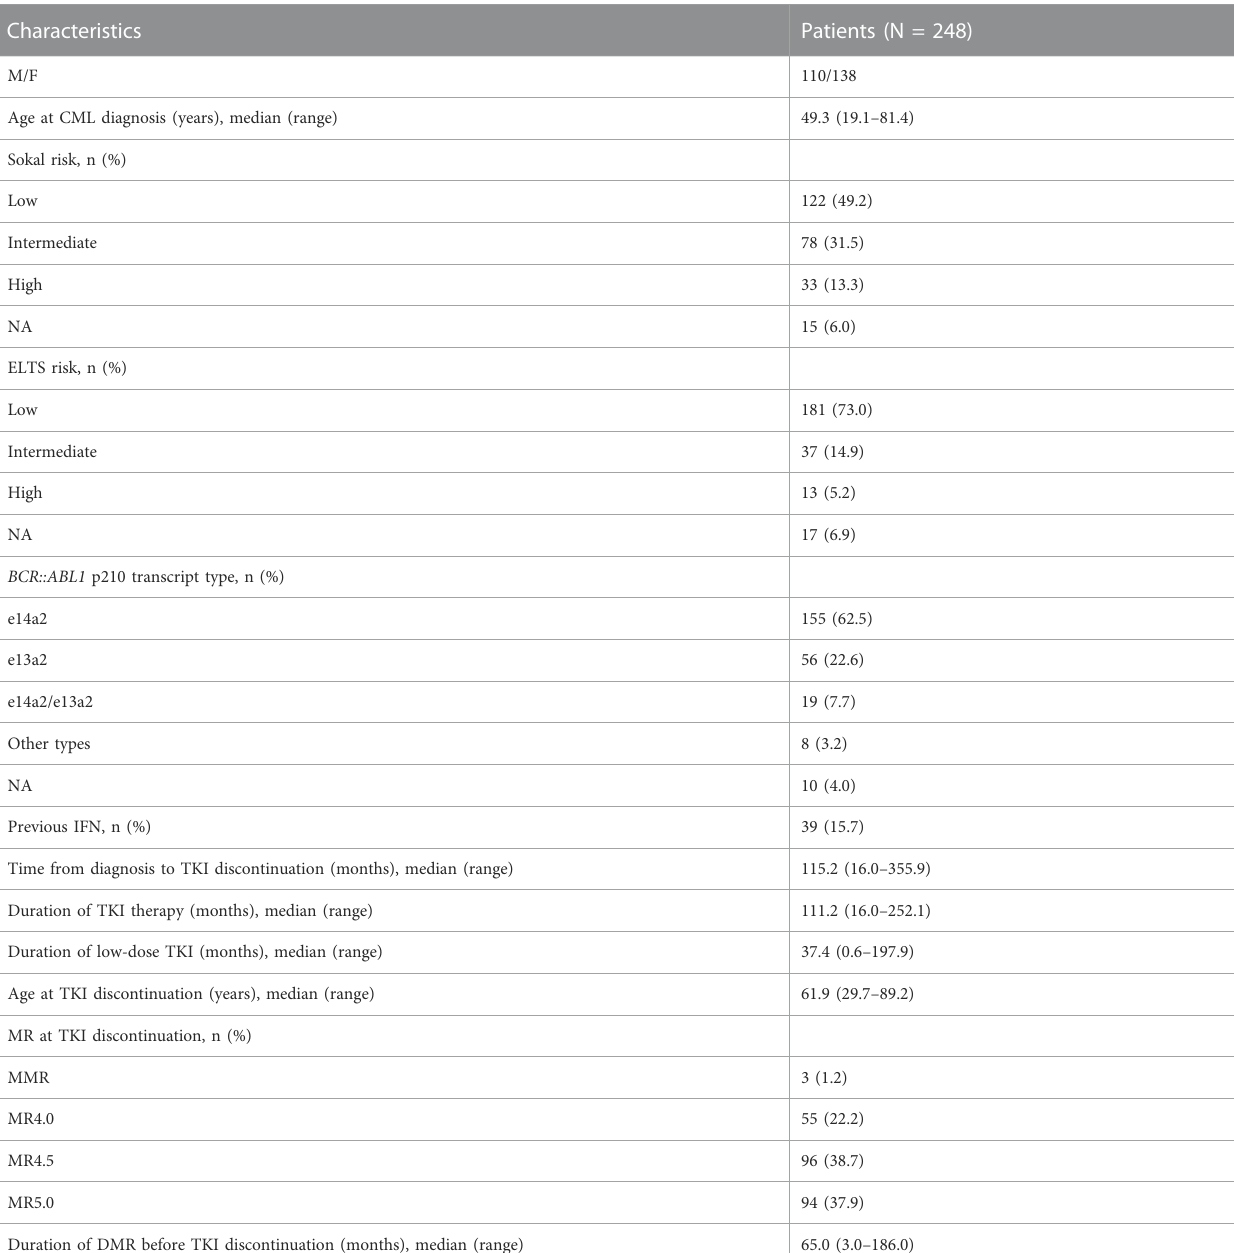
TABLE 1 Baseline demographics and clinical characteristics of 248 CML patients.